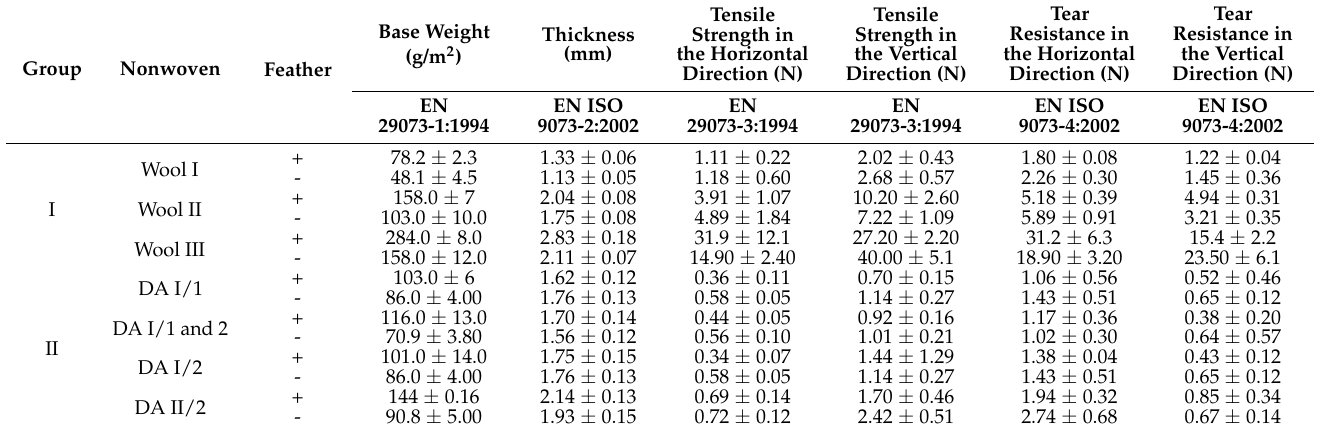
Table 2. The mechanical properties of the tested materials ( ±